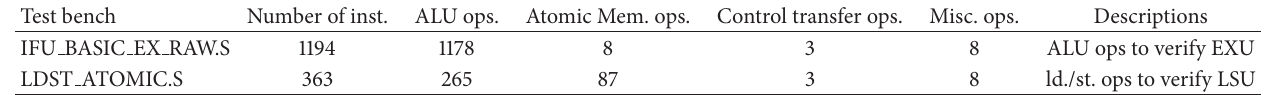
Table 2: Test benches